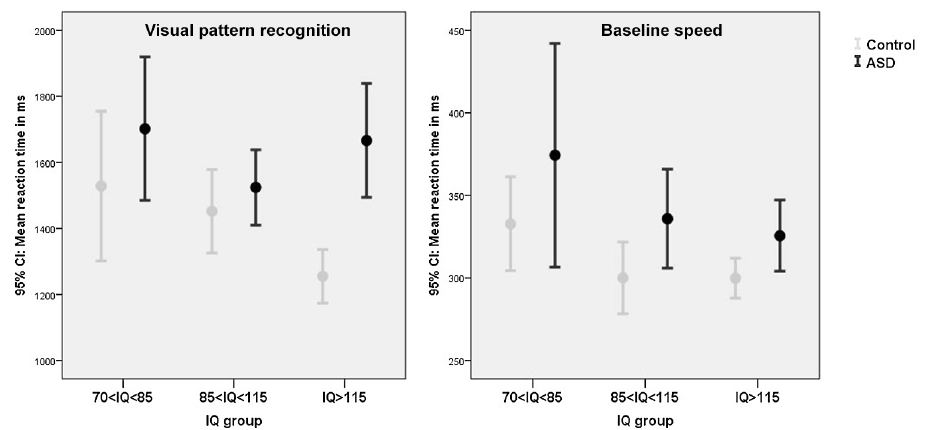
Fig 4. The effect of ASD and IQ on visual pattern recognition and baseline speed. Measures of speed are depicted. Please see S3 Fig for measures of accuracy (visual pattern recognition) and variability (baseline